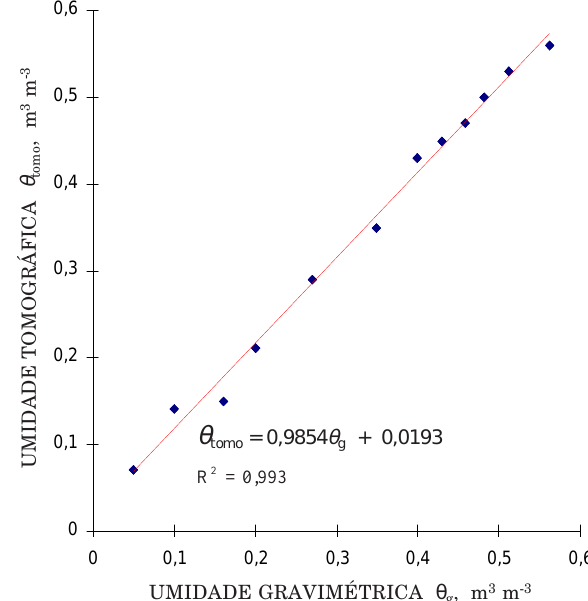
Figura 3. Correlação entre as umidades determi- nadas por gravimetria ( qqqqq para o